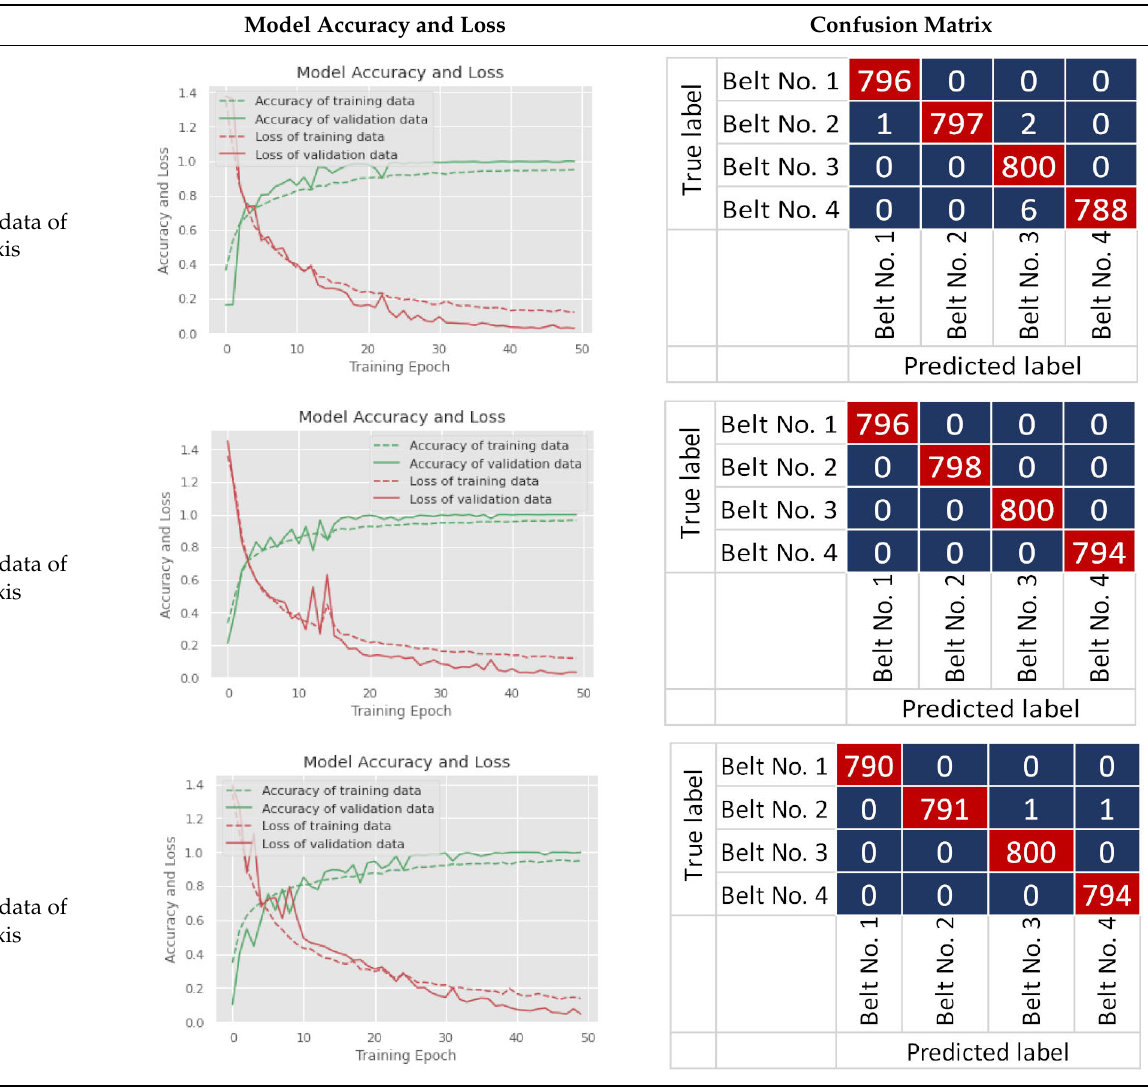
Table 4. Training curves and confusion matrix of double-axis vibration